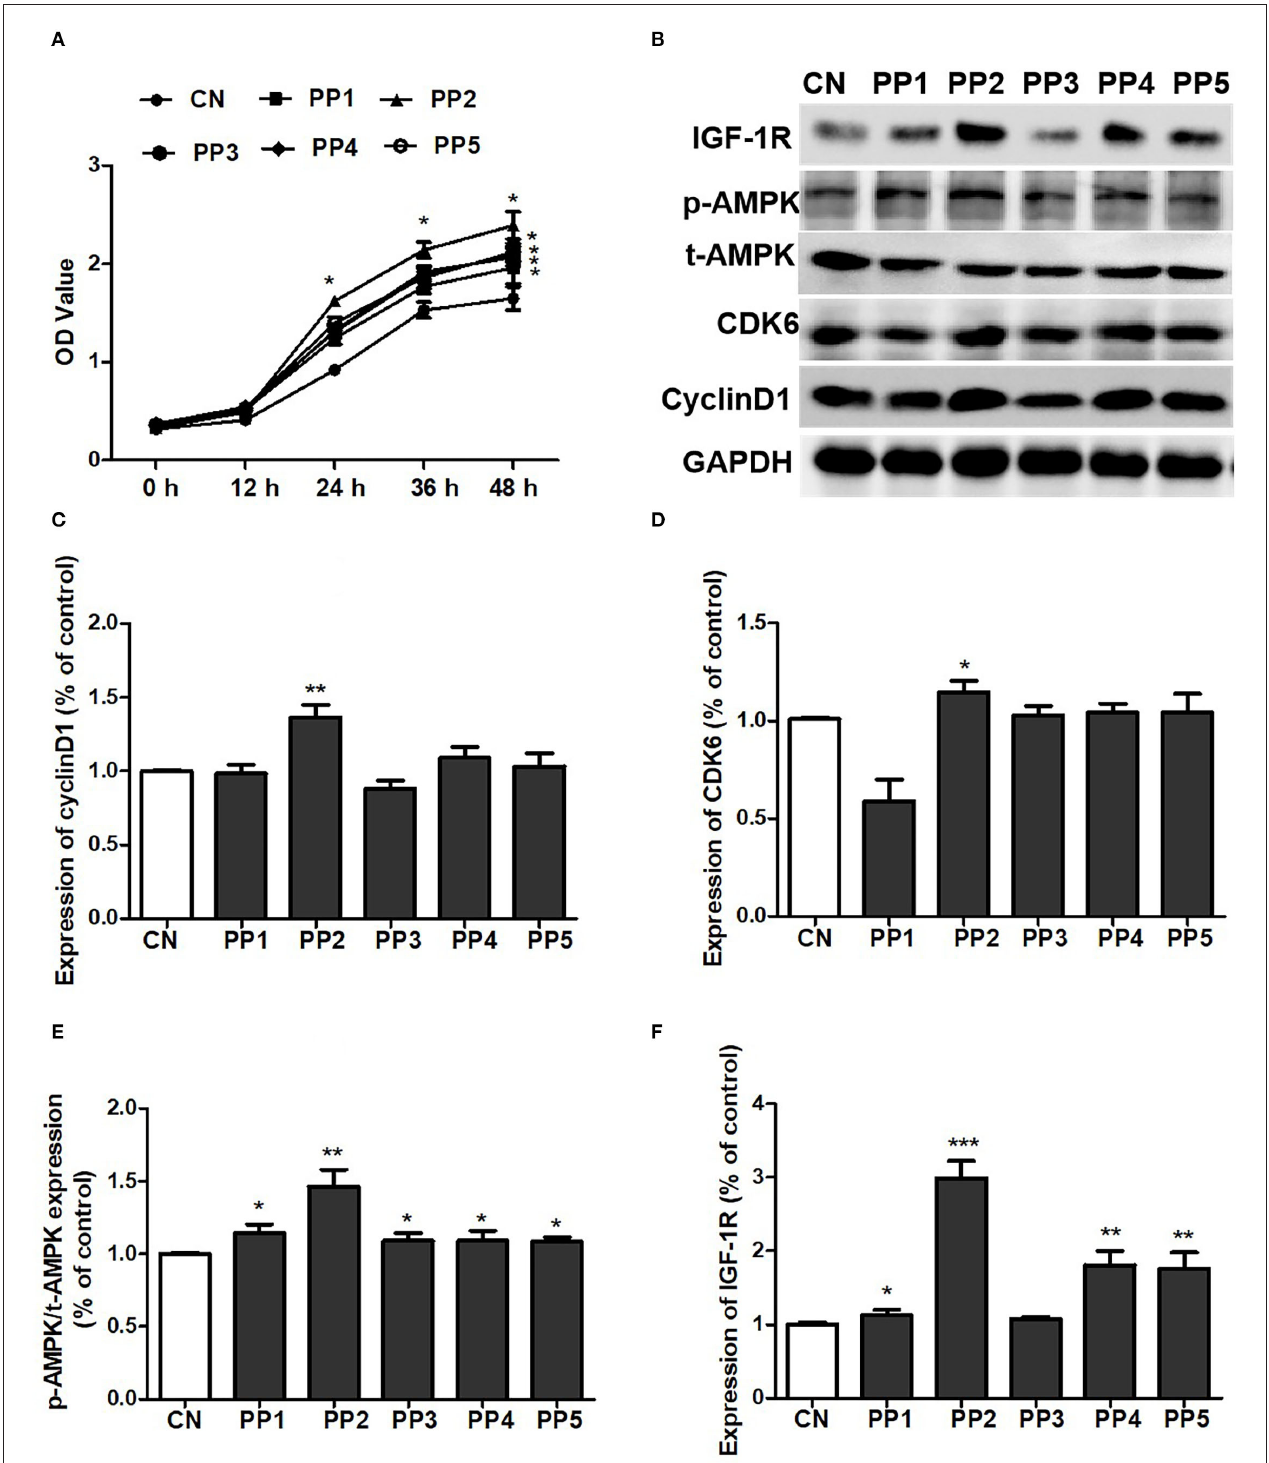
FIGURE 6 | PP2 largely promoted the proliferation of C2C12 cells. (A) Effect of PP1, PP2, PP3, PP4, and PP5 on the growth of C2C12 cells; (B) effect of PP1, PP2, PP3, PP4, and PP5 on the expression of IGF-1R, p-AMPK, t-AMPK, cyclin D1, and CDK6; (C) statistical analysis of cyclin D1 expression; (D) statistical analysis of CDK6 expression; (E) statistical analysis of p-AMPK/t-AMPK expression; (F) statistical analysis of IGF-1R expression. The significant difference between groups was validated with one-way ANOVA using GraphPad Prism 6, * p < 0.05, ** p < 0.01, *** p < 0.001 vs. CN group (n = 5/group). Data are presented as mean ± standard deviation (M ±